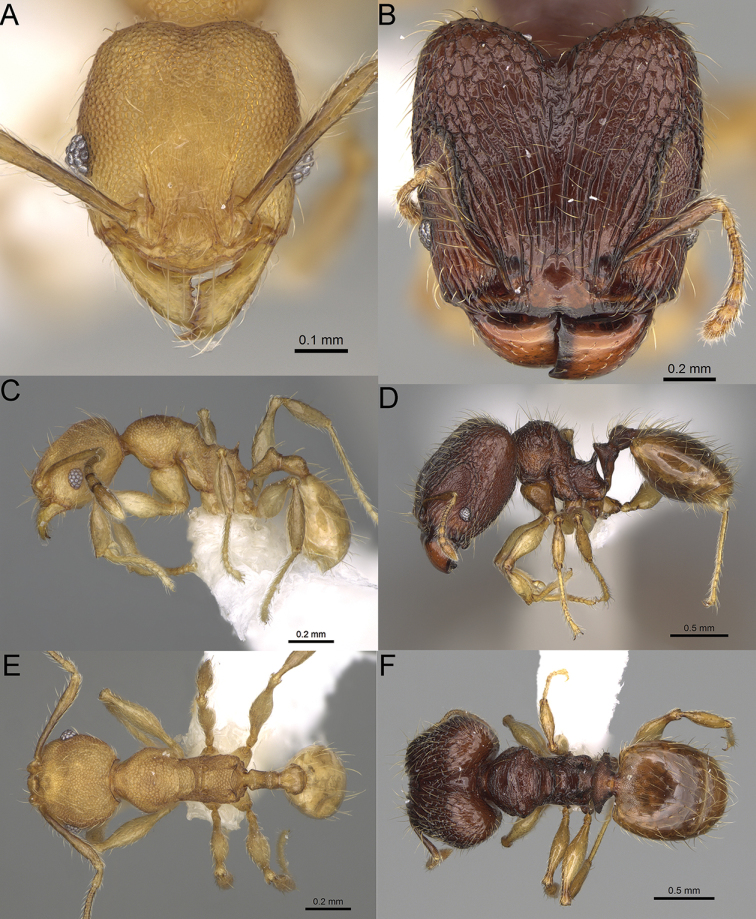
Pheidole
rugocephala sp. nov., full-face view (A), profile (C), and dorsal view (E) of paratype minor worker (CASENT0198470) and full-face view (B), profile (D), and dorsal view (F) of holotype major worker (CASENT0923224).